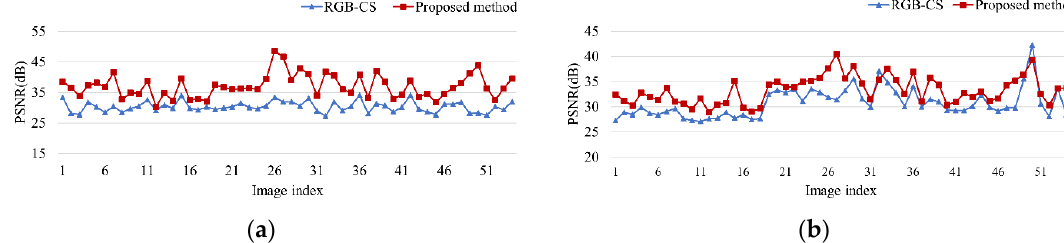
Figure 10. Peak-signal-to-noise-ratio (PSNR) comparison of RGB-CS [21] and the proposed method ( a ) The separated RGB image, ( b ) the separated NIR image. Table 1. The Simulation Conditions.